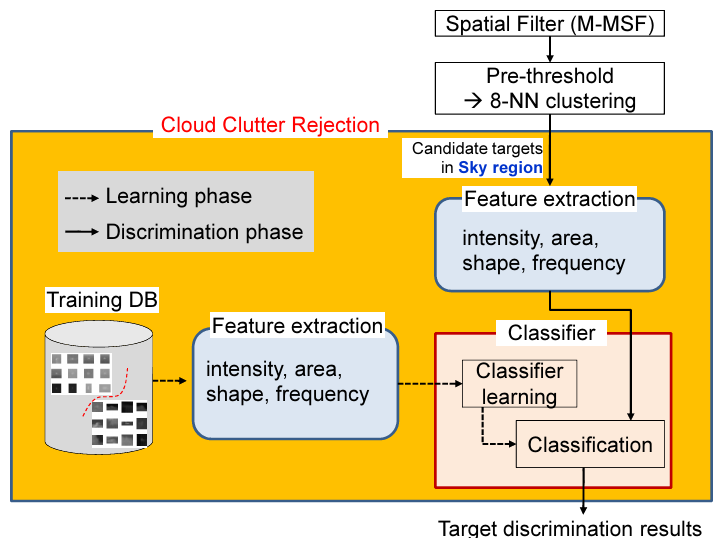
Figure 13. Overall flow of the target